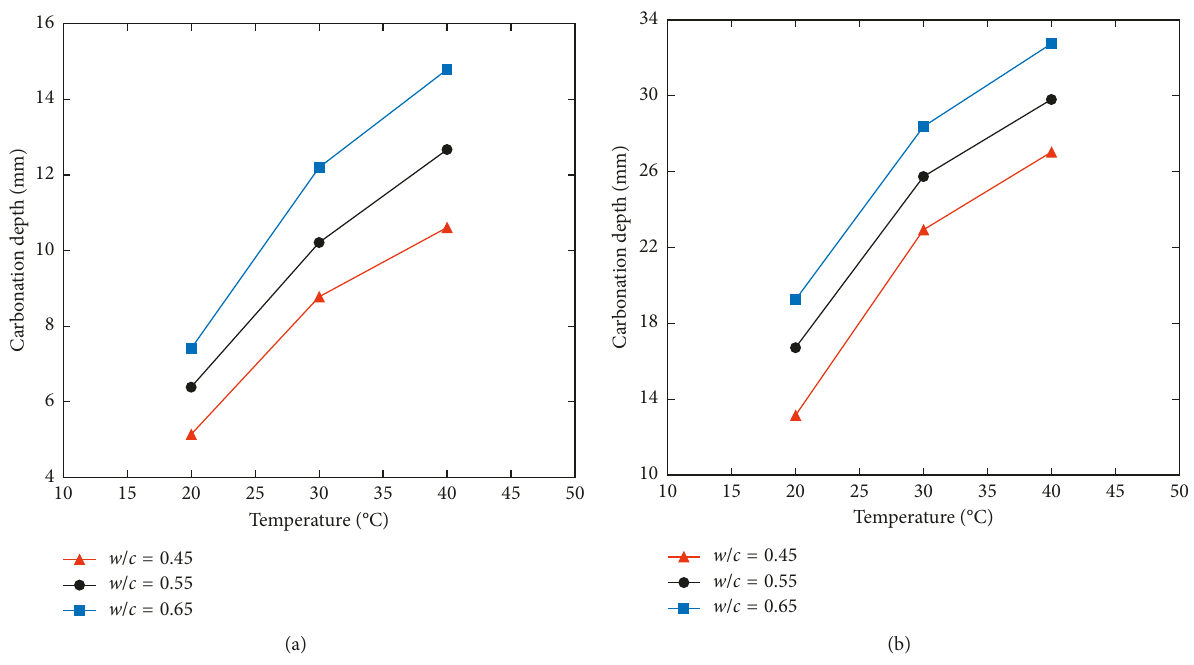
Figure 13: Curves of temperature and carbonation depth: (a) carbonation time for 7 days and (b) carbonation time for 56 days.